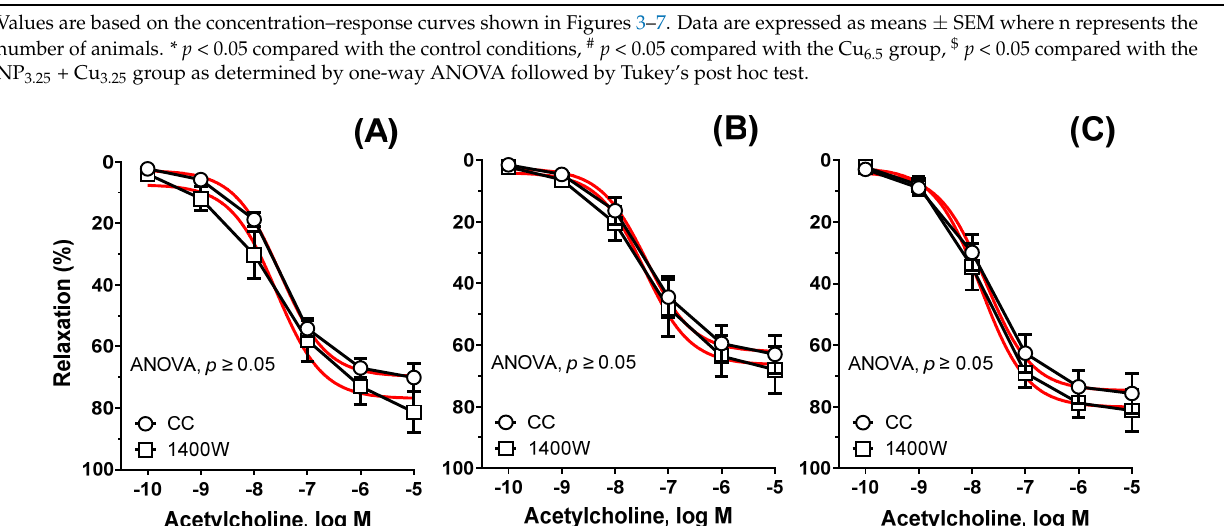
(AUC: × 1.39, Figure 6B), and NP 6.5 (AUC: × 1.52, Figure 6C) fed rats. This was not observed in the control group Cu 6.5 (AUC: × 1.02, Figure